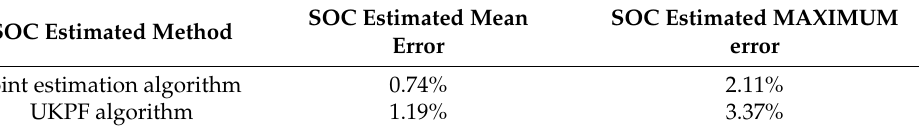
Table 2. SOC estimated results.